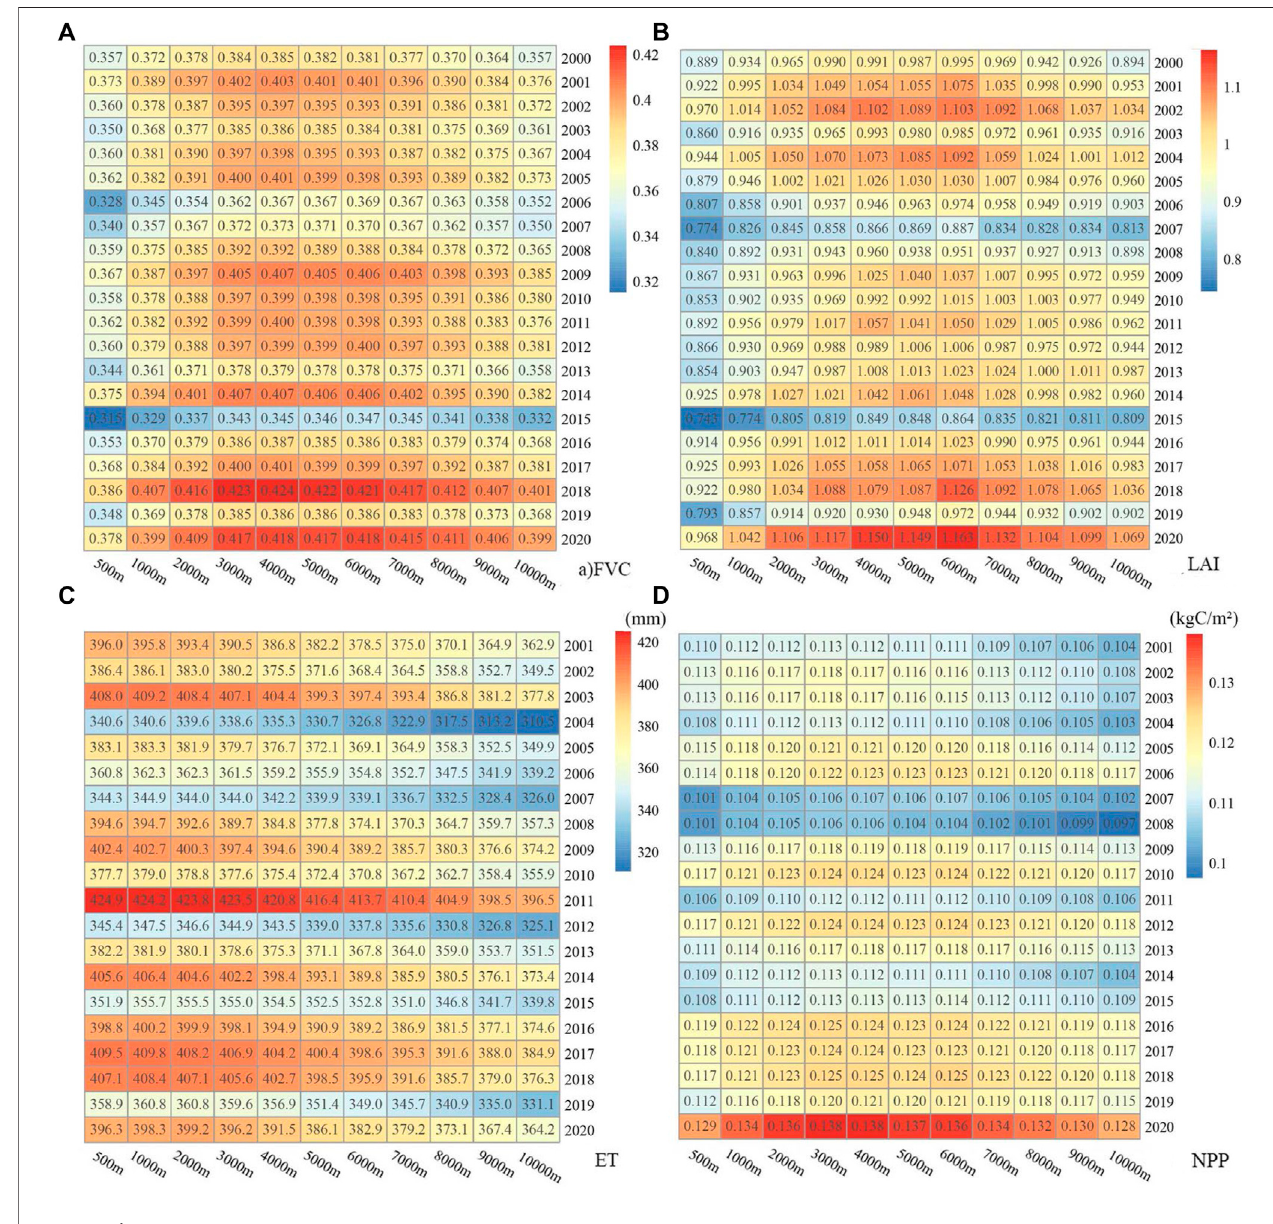
FIGURE 5 | Ecosystem service indicator variations across time and distance. ( (A) FVC; (B) LAI; (C) ET; (D) NPP).